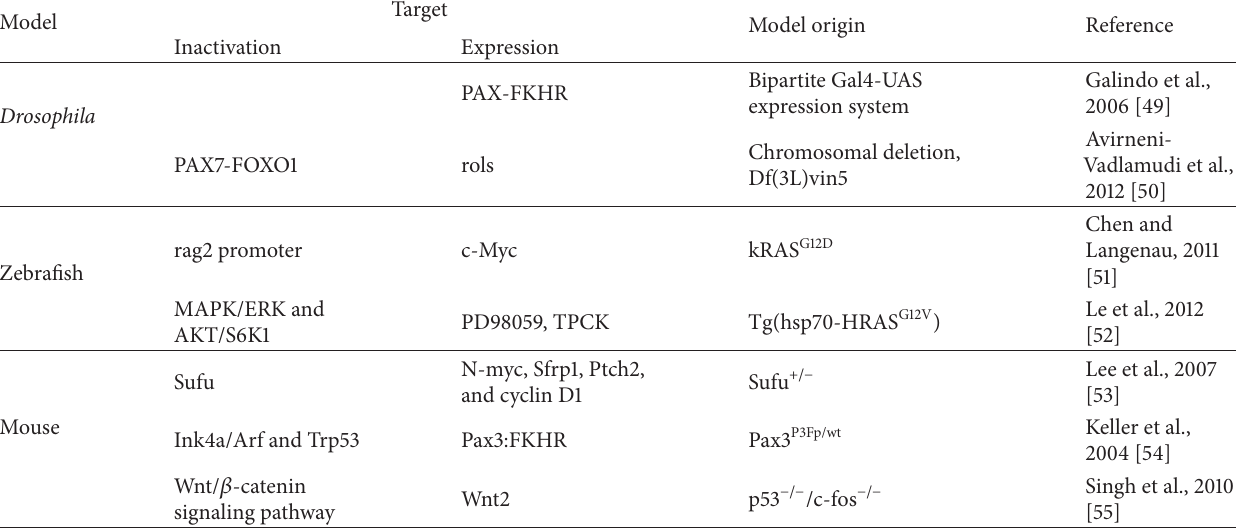
Table 5: In vivo animal models of